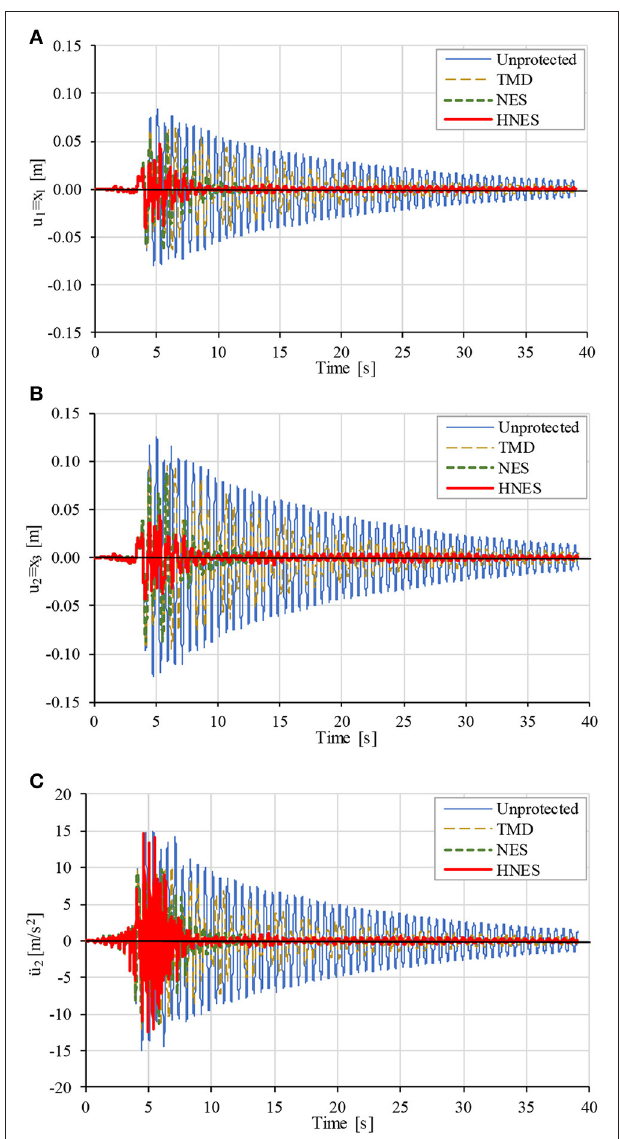
FIGURE 6 | Time history responses of the model structure: (A) bottom floor displacement u